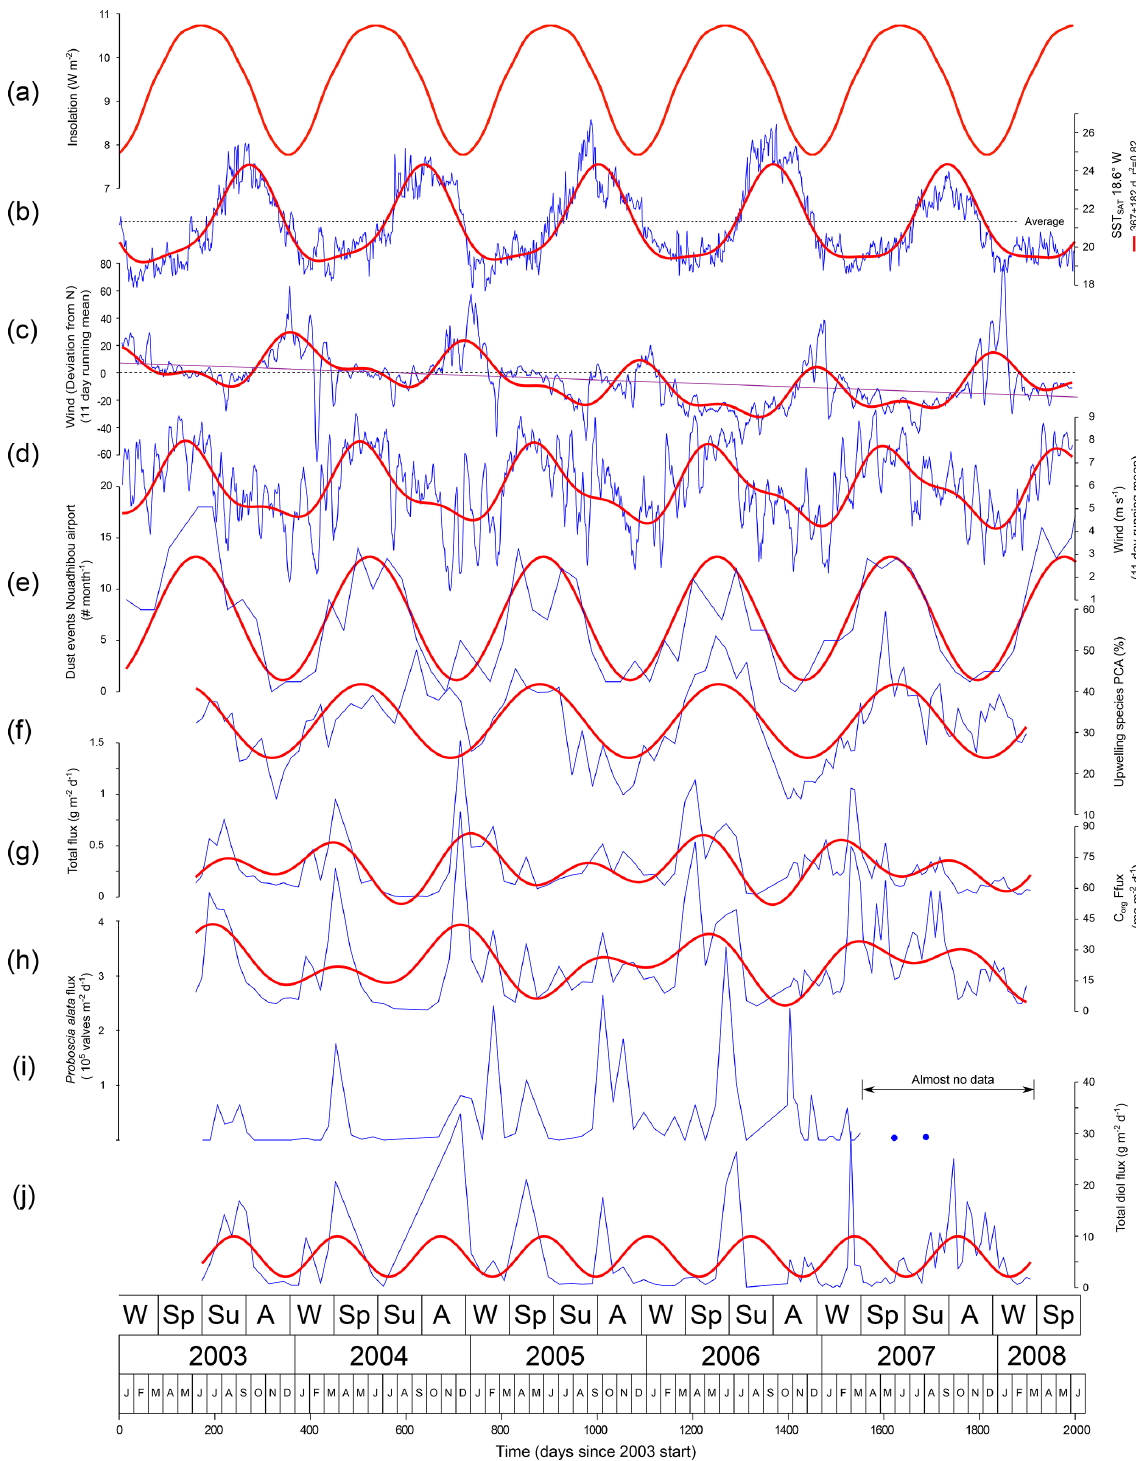
Figure 3. Variation in external variables and the total diol flux through time for CBeu1–5. Thin blue lines connect measured values (for wind parameter 11d moving average). Thick red lines, the most important frequency components. Note that most parameters have a dominant annual cycle modulated by a semiannual cycle. The total diol flux (graph J) is dominated by a 257d cycle. For wind direction (c) the scale runs from east (positive), through north (zero) to west